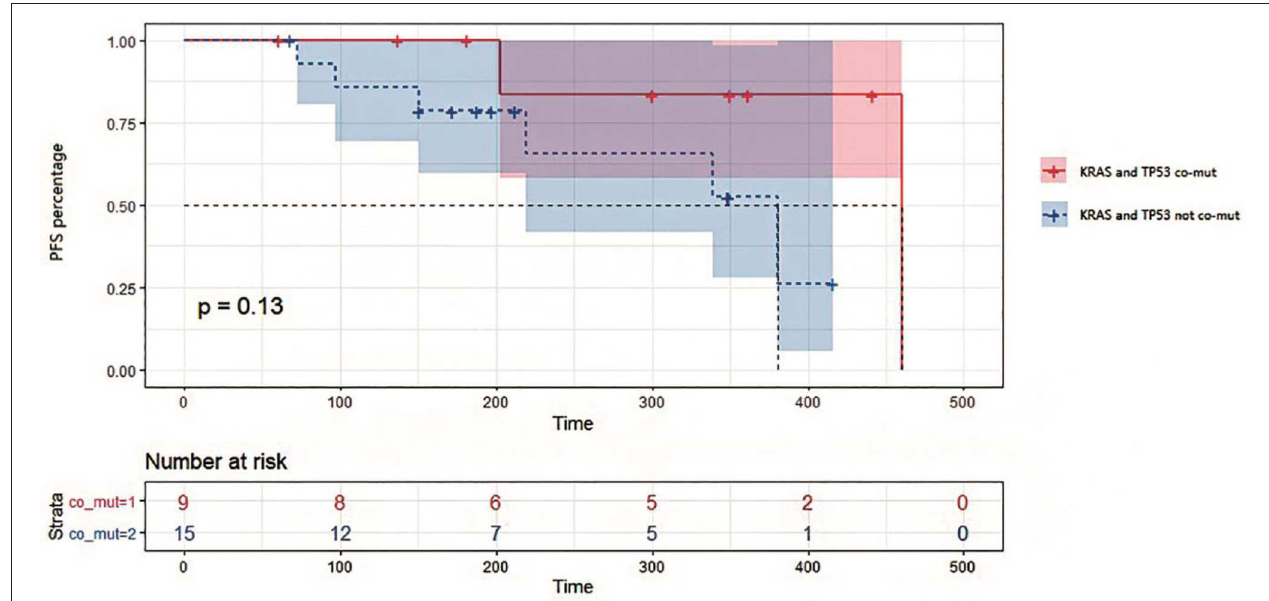
FIGURE 5 | Kaplan-Meier survival analysis on progression-free survival in patients with or without KRAS and TP53 co-mutations in tissues. Survival curves were compared by Log-rank (Mantel-Cox) test. P = 0.13 for statistical comparison between the two groups. Data was represented with 95% confidence interval.